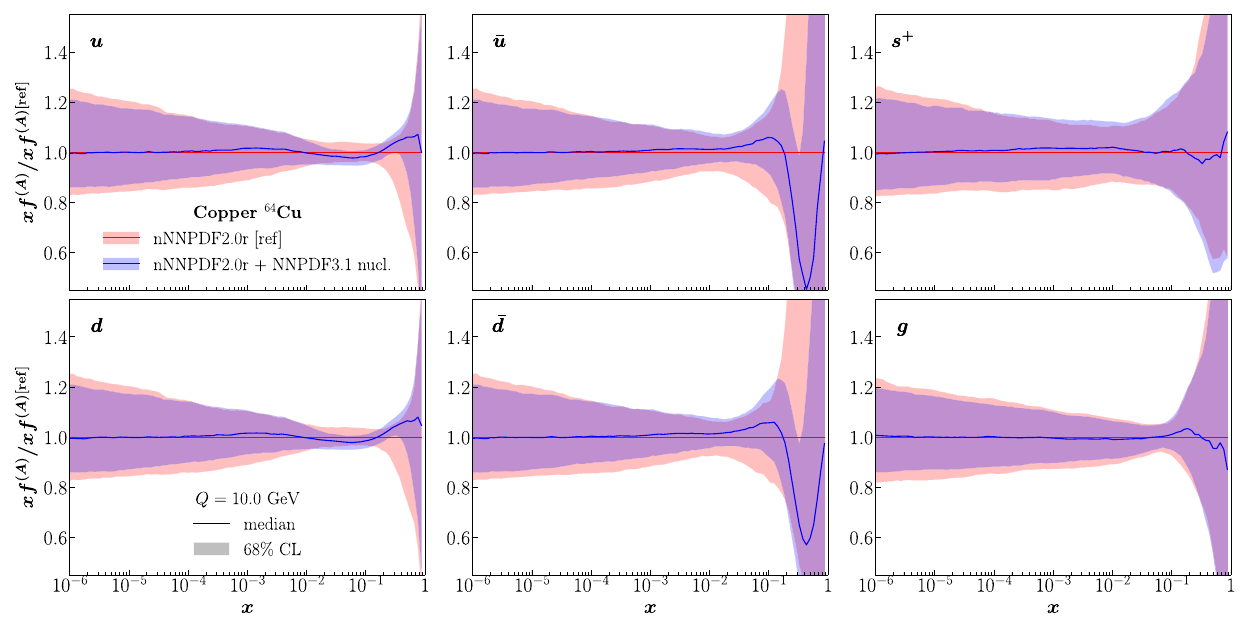
Fig. 22 Same as Fig. 21 for the nPDFs corresponding to copper ( A = 64)